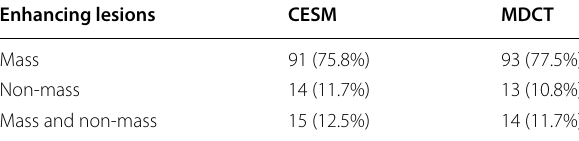
Table 2 Lesions enhancing pattern in CESM and MDCT Enhancing